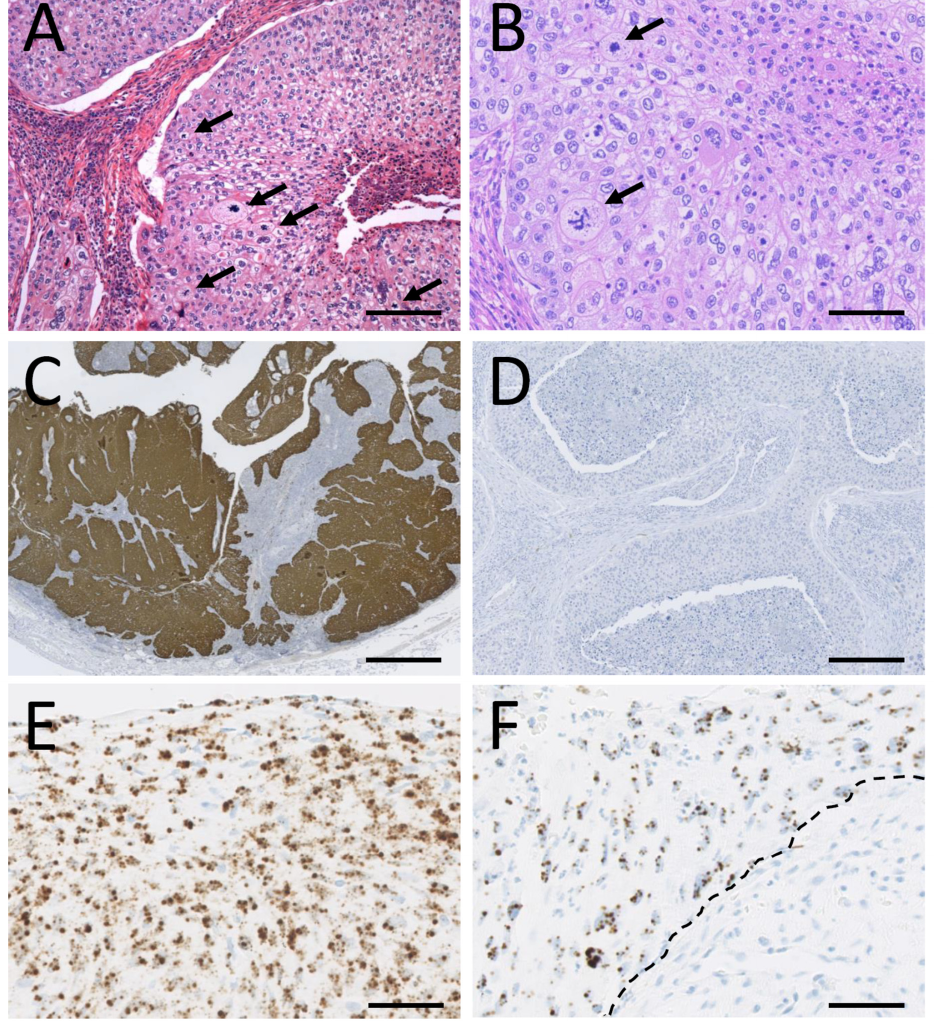
Figure 3. ( A ) An HPV16-positive non-keratinizing squamous cell carcinoma of the lacrimal sac consisting of highly pleomorphic tumor cells with eosinophilic cytoplasm and hyperchromatic nuclei. Numerous aberrant mitoses (arrows) are present (Hematoxylin and eosin (HE), scale bar = 150 μ m). ( B ) A pleomorphic HPV11-positive non-keratinizing squamous cell carcinoma with transitional cell morphology of the lacrimal sac with prominent nucleoli and aberrant mitoses (arrows) (HE, scale bar = 100 μ m). ( C ) The same tumor as in A, expressing the tumor suppressor p16—a surrogate marker of high-risk HPV infection (p16 immunohistochemistry (IHC), scale bar = 400 μ m). ( D ) The low-risk HPV11-associated carcinoma in B does not express p16 (p16 IHC, scale bar = 300 μ m. ( E ) Deregulated expression of high-risk HPV E6/E7 with E6/E7 expression in the superficial epithelial layers (chromogenic in-situ hybridization with high-risk HPV E6/E7 mRNA cocktail probe, scale bar = 100 μ m) in the same tumor as illustrated in A. By sequencing, the tumor was HPV16-positive. ( F ) Deregulated expression of low-risk E6/E7 transcripts in the same tumor as illustrated in B (chromogenic in-situ hybridization with low-risk HPV E6/E7 mRNA cocktail probe, scale bar = 100 μ m) confirmed HPV11-positive by sequencing. Note the sharp demarcation (dashed line) in viral expression between the tumor tissue in the top and the surrounding stroma below.